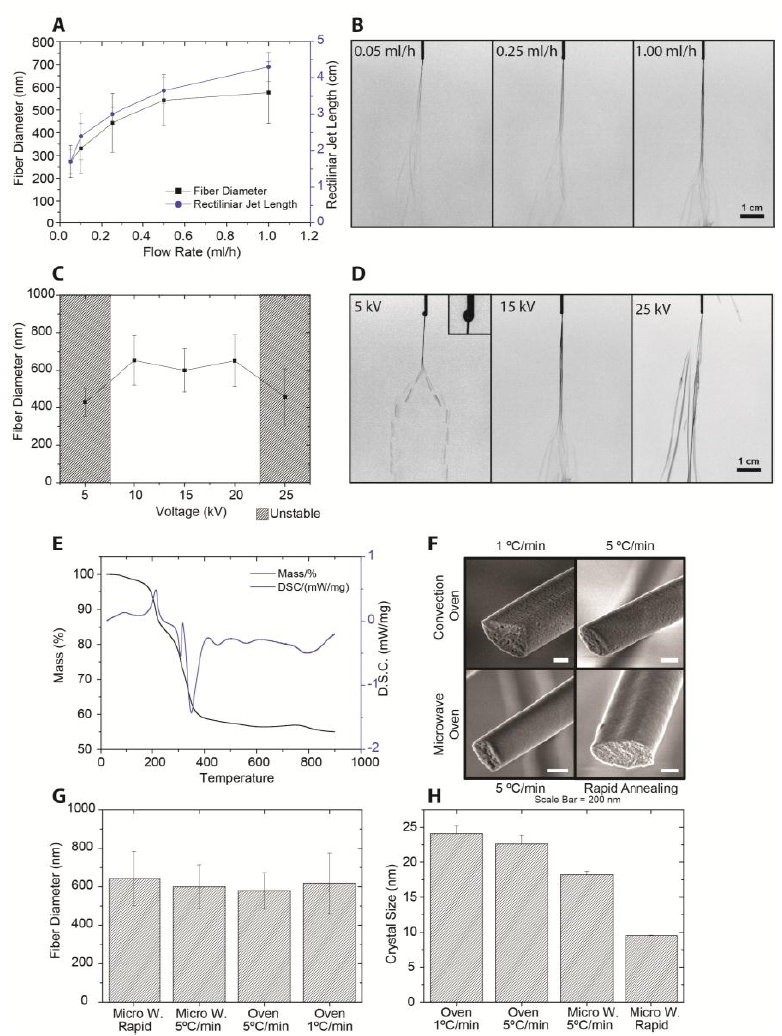
Figure 5. ( A ) Influence of flow rate on electrospinning process. Flow rate 0.05–1 mL/h. Fiber diameter (black squares) and rectilinear jet length (blue circles) at different flow rates are shown; ( B ) rectilinear jet length at flow rates of 0.05–1 mL/h; ( C ) influence of potential between spinneret and collector plate. Fiber diameter at voltages between 5 and 25 kV are shown; ( D ) electrospinning jet at voltages of 5–25 kV; ( E ) thermogravimetic analysis and differential scanning calorimetry (5 °C/min in air); ( F ) surface morphology of ceramic fibers after different annealing procedures; ( G ) fiber diameters after different annealing procedures; and ( H ) crystallite size of ceramic fibers after different annealing